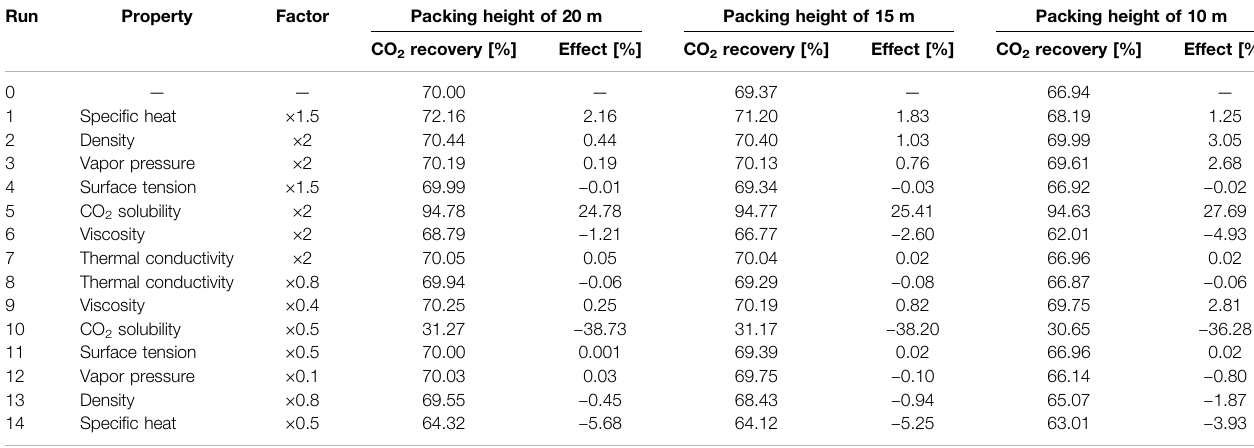
TABLE 4 | Sensitivity analysis of solvent properties with Bravo et al. (1985) correlations (lean solvent fl ow rate of 3,495 kg/s). Run